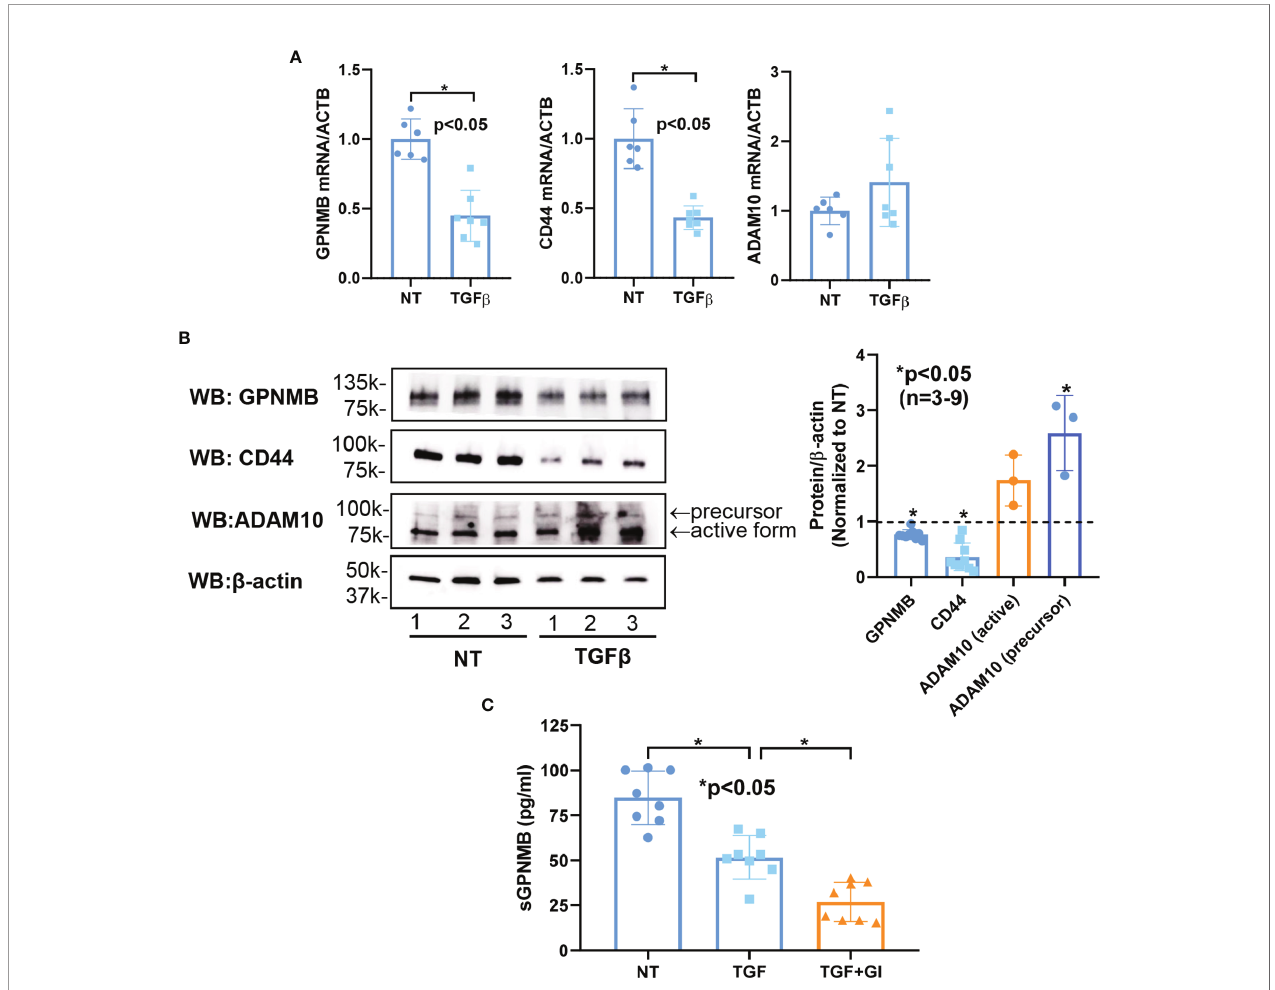
FIGURE 3 | Effect of TGF b on GPNMB, CD44, and ADAM10 in normal dermal fi broblasts. (A) TGF b signi fi cantly downregulated both GPNMB and CD44 in normal fi broblasts, but had minimal effect on ADAM10 expression. (B) At the protein level, signi fi cantly lower levels of GPNMB and CD44 were observed after TGF b treatment. In contrast, ADAM10, speci fi cally the precursor form, was signi fi cantly upregulated by TGF b . (C) The soluble form of GPNMB was signi fi cantly lower in culture media from TGF b -treated fi broblasts. Inhibition of ADAM10 by GI254023X (GI) further reduced the amount of sGPNMB in culture media. n=number of subjects. Results are expressed as mean +/- SD and p < 0.05 was considered signi fi